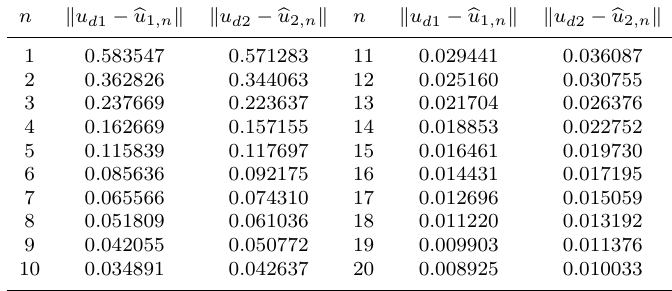
Table 4. Errors of approximations of the exact solution n